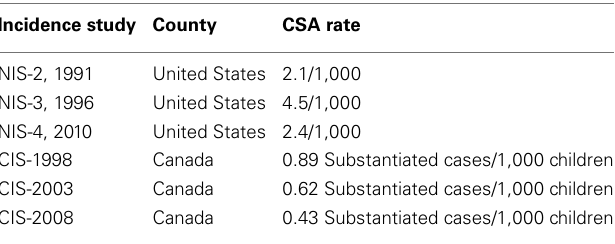
Table 1 | NorthAmerican rates of reported child sexual abuse (CSA) from national incidence